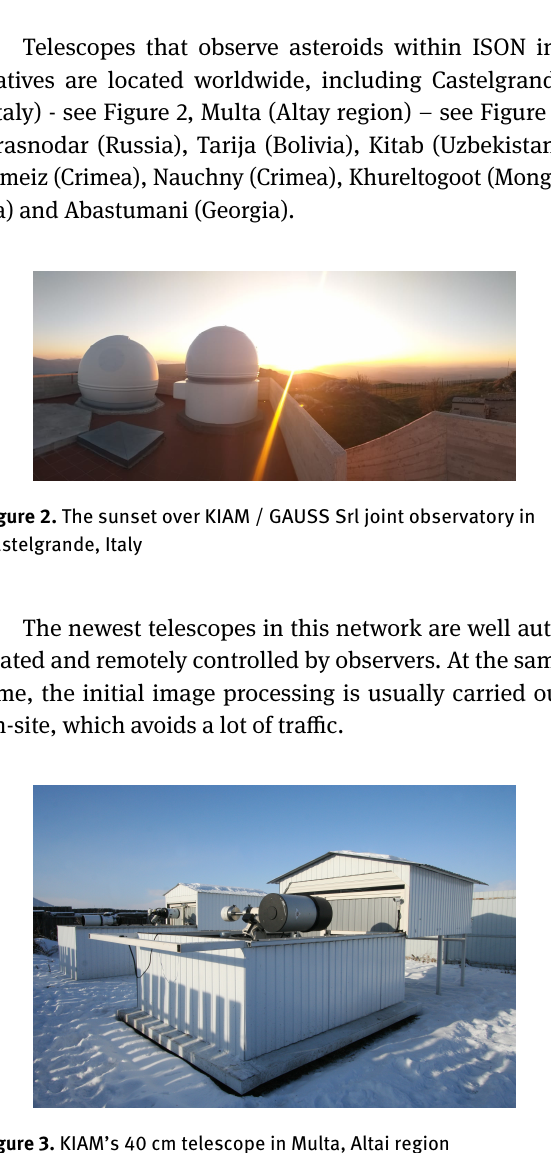
Figure 3. KIAM’s 40 cm telescope in Multa, Altai